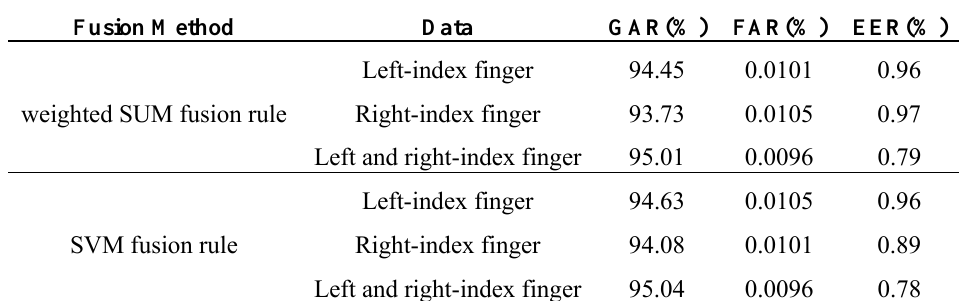
Table 5. Performance from the combination of SIFT, shape, and orientation of vein (database